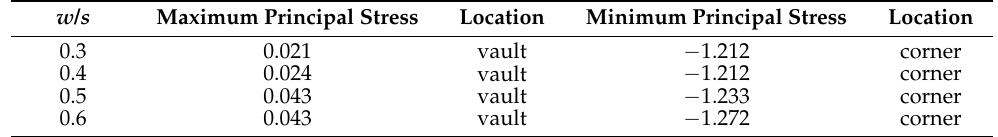
Table 4. Greatest values of principal stresses with different w / s ratios (unit: